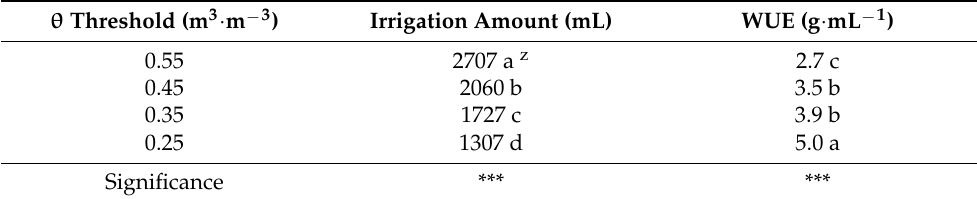
Table 3. Irrigation amount, water use efficiency (WUE) of 1-year-old cymbidium “Hoshino Shizuku” at the harvest after 42 weeks of treatments, as influenced by 0.25, 0.35, 0.45, and 0.55 θ thresholds (m 3 · m − 3